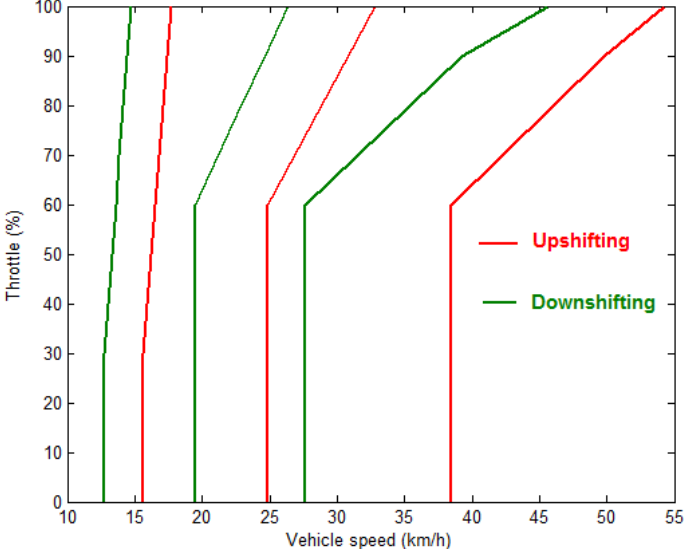
Figure 6. The optimized extracted two-parameter gear shift schedule.